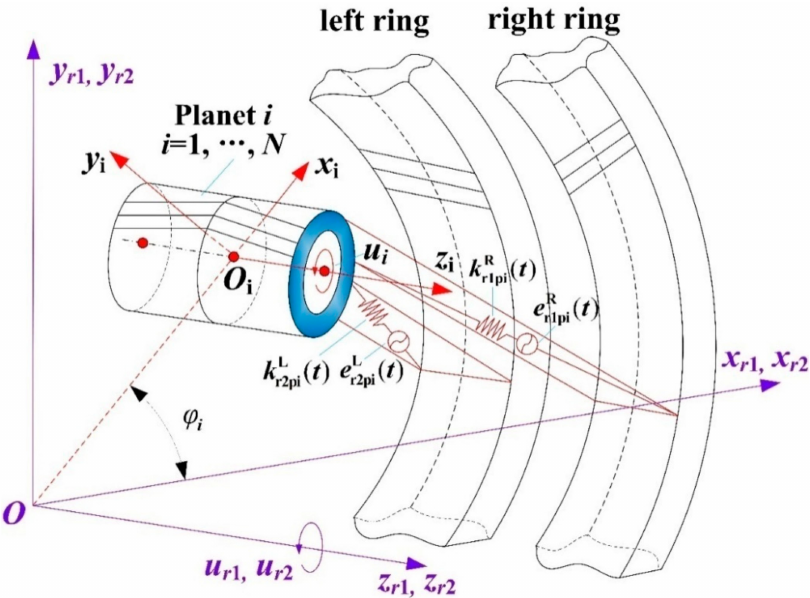
Figure 5. Dynamic model of the i th herringbone planet-ring gear